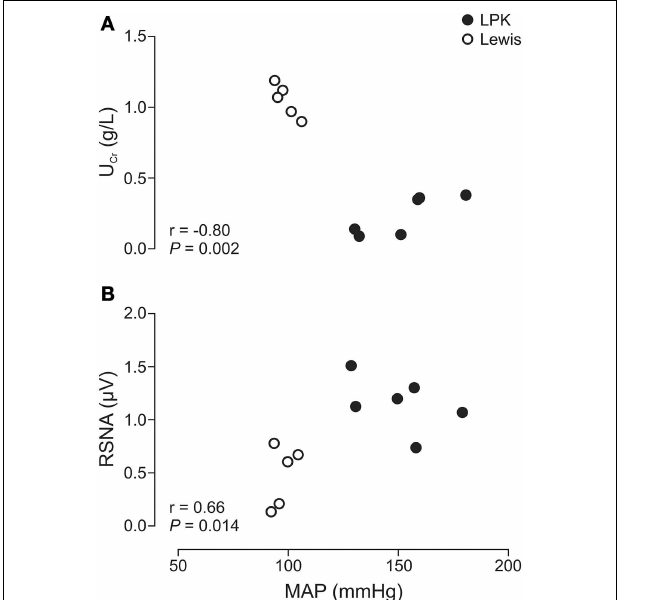
FIGURE 3 | Mean arterial pressure (MAP) and renal sympathetic nerve activity (RSNA) responses to peripheral chemoreflex activation in Lewis and Lewis Polycystic Kidney (LPK) rats. (A) Data points are 1-min averages of MAP and RSNA measured for 1min before (time zero) and 5min during a hypoxic challenge (10% O 2 ). Results are expressed as mean ± SEM. Minimum n /group = 4. (B) Average change in MAP and RSNA during the challenge. Results are expressed as mean ±